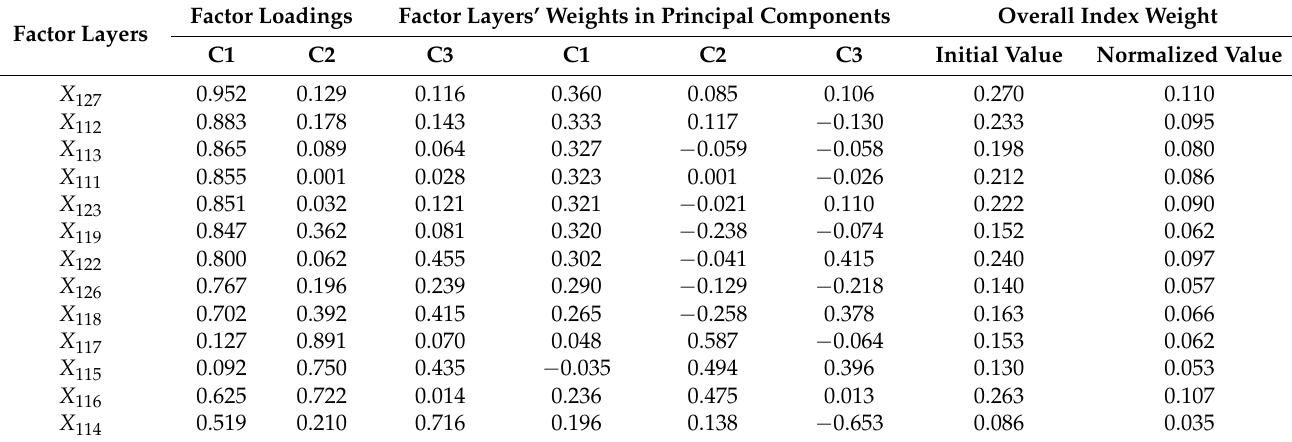
Table 3. The Loading and Weight of Each Factor Layer of the Rule Layer X 1